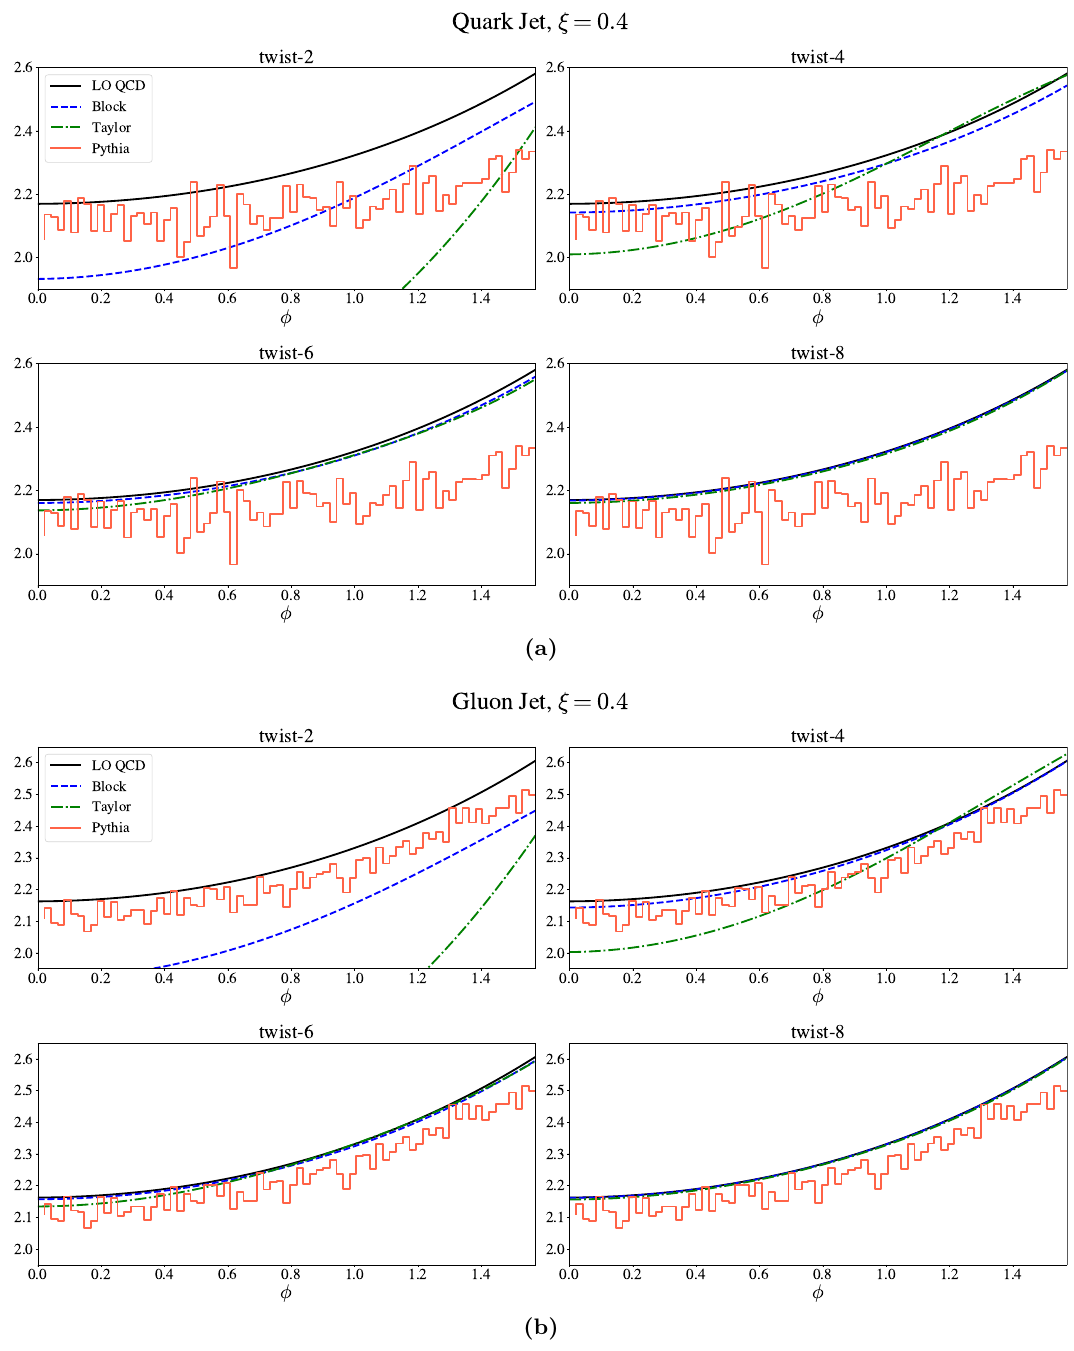
Figure 13. A slice of the leading order three-point correlator at ξ = 0 . 4 for quark jets in (a) and gluon jets in (b). We compare the full QCD result, the expansion in celestial blocks, the naive Taylor expansion, and the result from Pythia. The expansion in celestial blocks converges